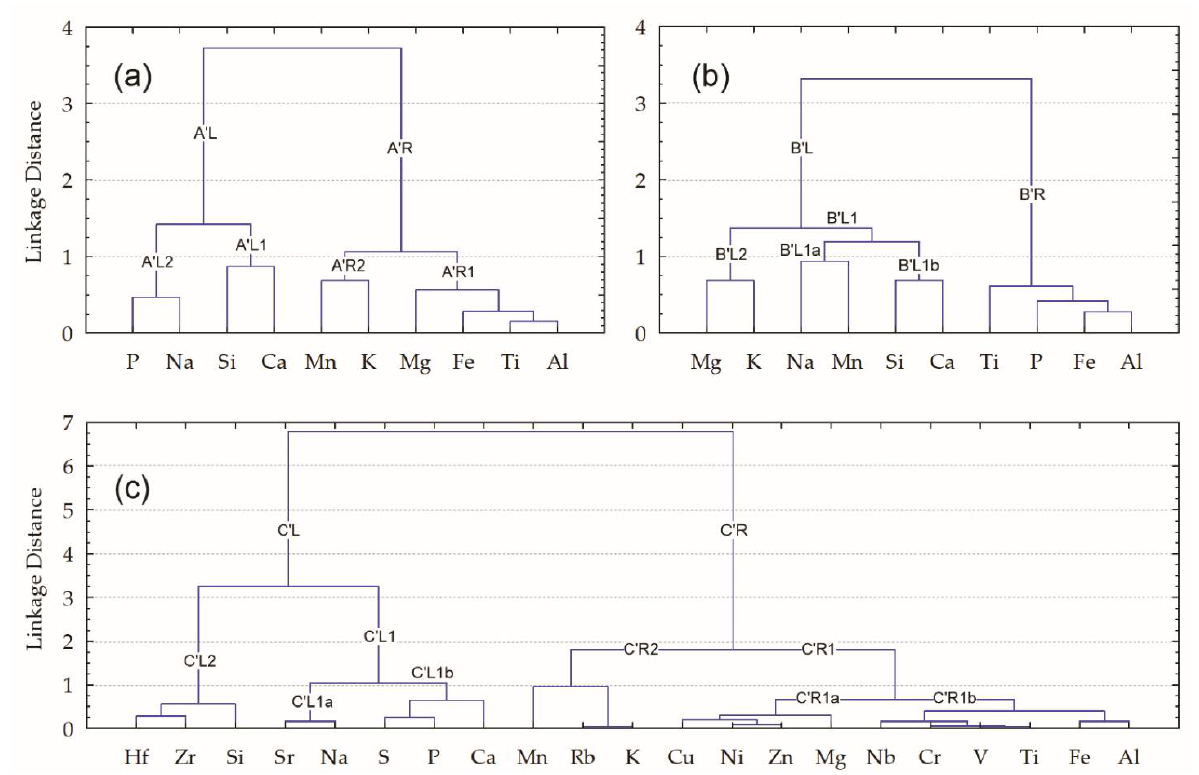
Figure 3. Cluster analysis (Ward’s method, Spearman distance matrix): ( a ) panel–dendrogram of the major elements in the bulk compositions of the pottery samples; ( b ) panel–dendrogram of the major elements in the clay matrix; ( c ) panel–dendrogram of the major and trace elements in the bulk composition.